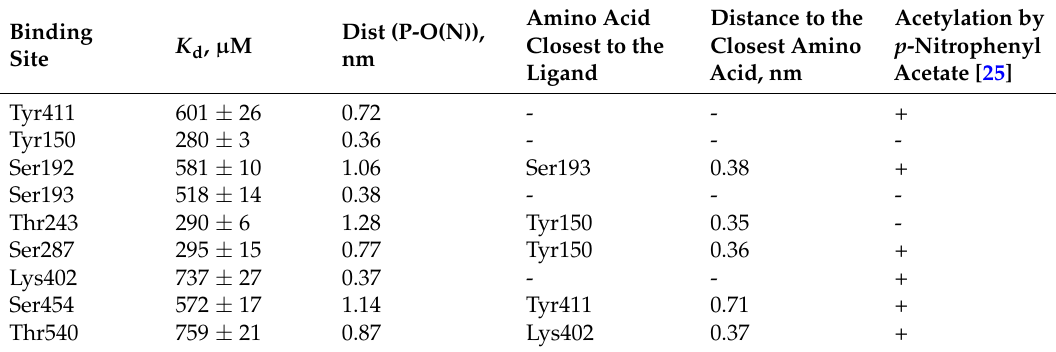
Table 1. The results of molecular docking of the P(-)C(-)-isomer of soman into the possible sites of phosphonylation or esterase activity of